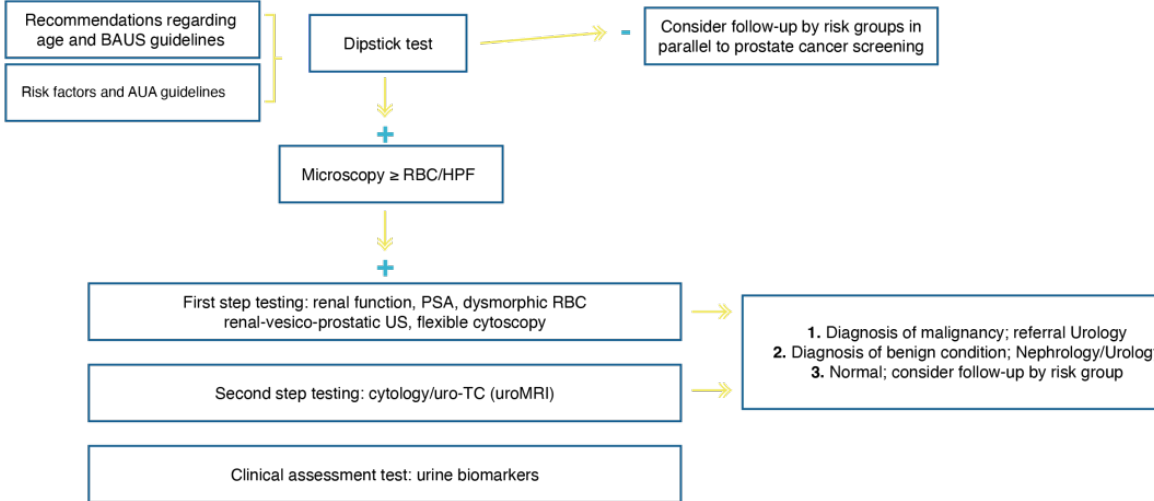
Figure 1. Clinical algorithm for use in a hematuria clinic (BAUS: British Association of Urological Surgeons, AUA: American Urological Association, PSA: prostate-specific antigen, RBC: red blood cells, US: ultrasound, uro-TC: computed tomography urography, uroMRI: magnetic resonance imaging urography).